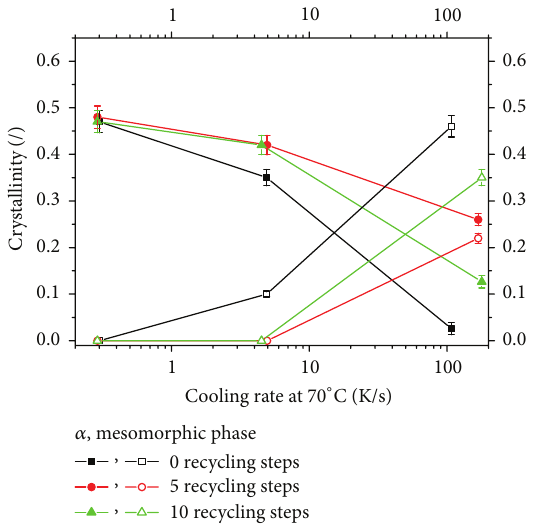
Figure 6: Content of 𝛼 (solid symbol) and mesomorphic phase (open symbol) in the samples assessed by WAXS spectra deconvo-